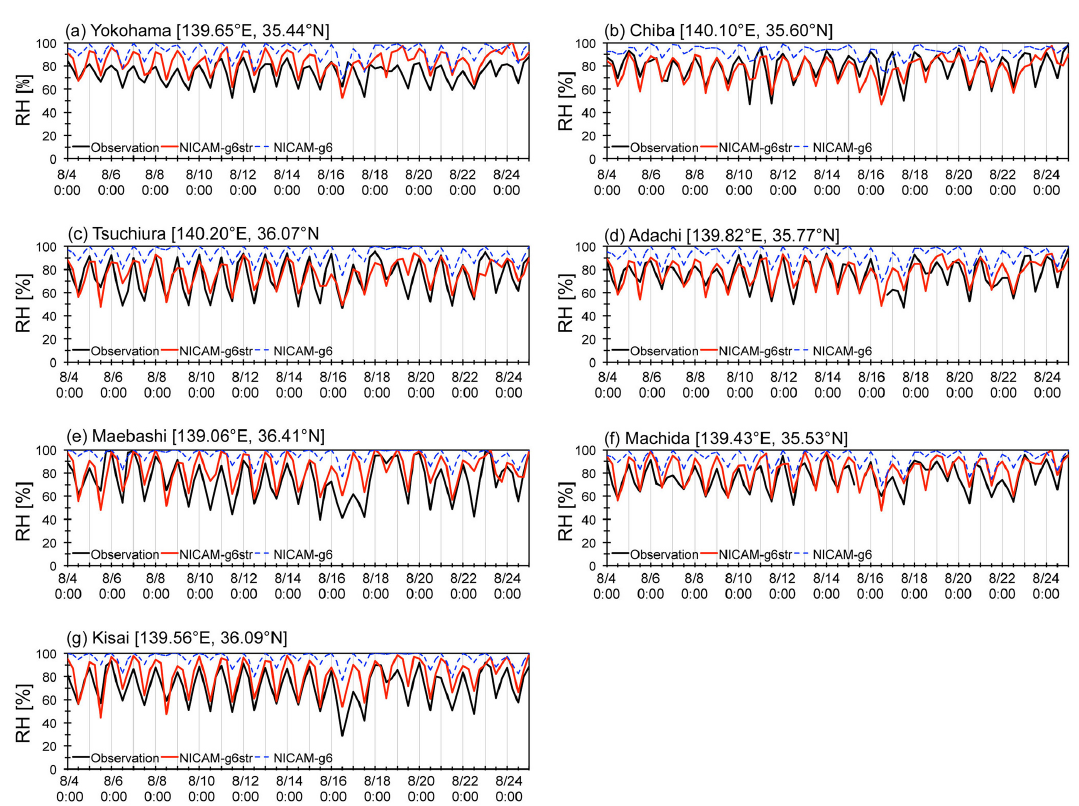
Figure 5. Same as Fig. 4 but for relative humidity